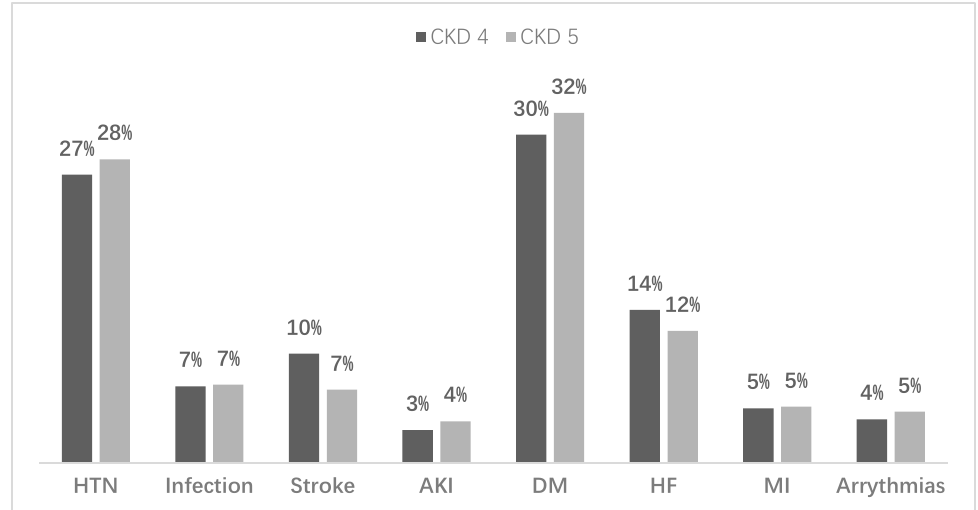
Figure 3. Comorbidity conditions among the study groups. CKD4: Chronic kidney disease grade 4 and grade 5. HTN: Hypertension, AKI: Acute Kidney Injury, DM: Diabetes Mellitus, HF: Heart Failure, MI: Myocardial Infarction. Table 2. Multivariate analysis of laboratory parameters and their correlation with Quality of